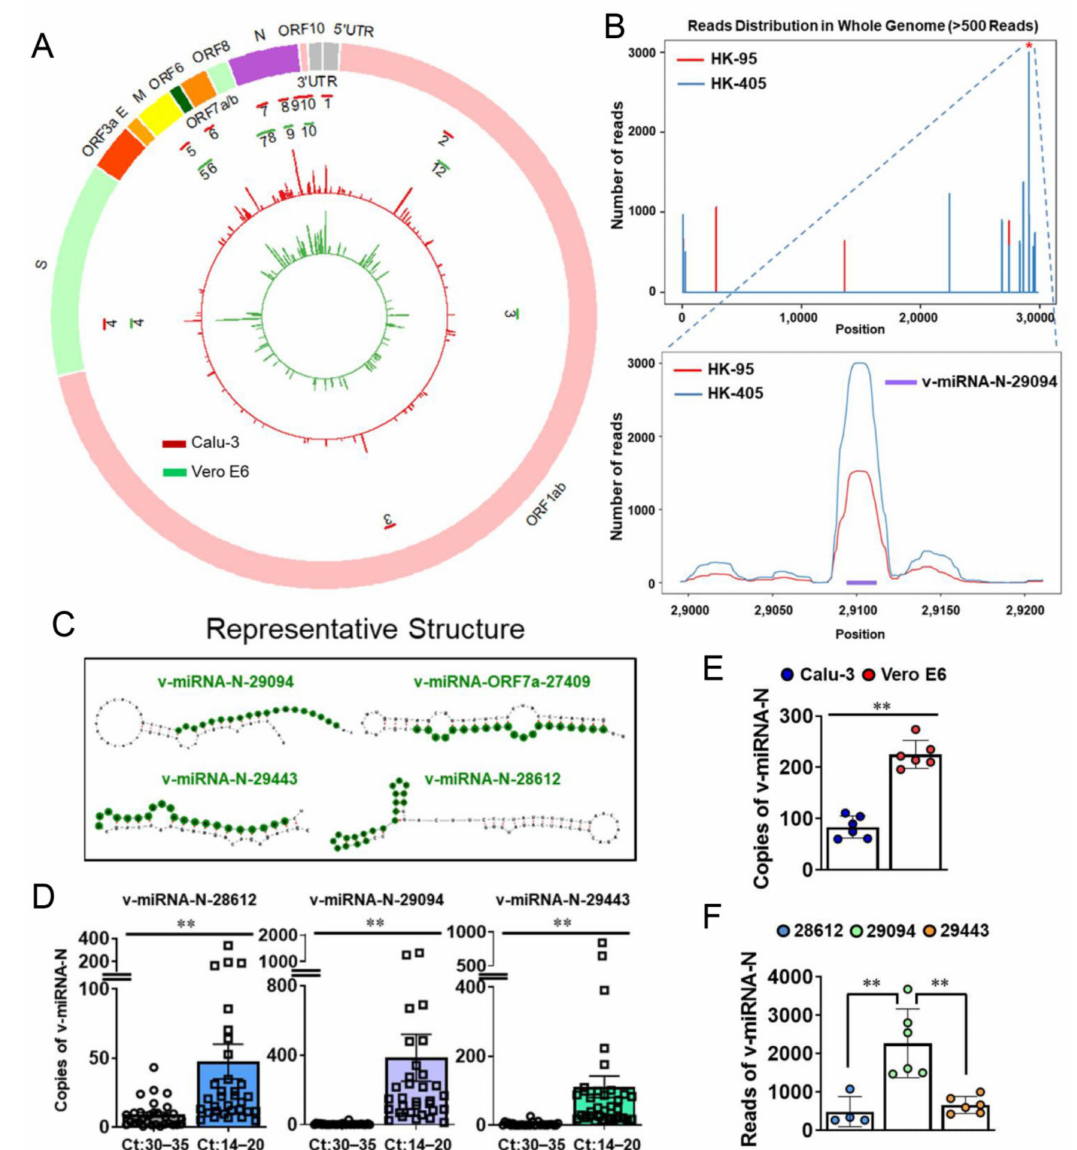
Figure 1. Detection of SARS-CoV-2-encoded v-miRNAs. ( A ) Genetic map and read distribution of SARS-CoV-2-encoded v-miRNAs in Calu-3 and Vero E6 cells. The inner green layer represents read distribution from Vero E6 cells and the middle red layer represents the read distribution of v-miRNAs from Calu-3 cells. The locations of the top ten v-miRNAs (in terms of read counts) are indicated as two circular layers of 10 short bars with the outer layer (red) for Calu-3 cells and inner layer (green) for Vero E6 cells. ( B ) Read distribution across the entire whole viral genome (>500 reads). The Y-axis shows the number of reads, and the X-axis shows the position of v-miRNAs. V-miRNA-N-29094 showed the highest peaks both in HK-95 and HK-405 samples isolated from Calu-3. ( C ) Representative predicted secondary structures of pre-miRNAs (gray). The encoded green color indicates the region for NGS-identified mature v-miRNAs. ( D ) Copy number of v-miRNA-N detected in COVID-19 patients. Significantly increased copy numbers of v-miRNA-28612, v-miRNA-229094, v-miRNA-29443 were detected in clinical samples from COVID-19 patients with high viral load (low Ct: 14–20) compared to those with low viral load (high Ct:30–35). The mean ± SD is shown for RT-ddPCR results. n = 30–33; ** p < 0.01. ( E ) Expression levels of v-miRNA-N-28612 are quantified by RT-ddPCR in Calu-3 and Vero E6 cells. The mean ± SD is shown for RT-ddPCR results. ** p < 0.01. ( F ) NGS reads of the identified three v-miRNA-N are determined in Calu-3 cells. The mean ± SD is shown for results obtained from small RNA-seq. ** p < 0.01. Ct, threshold cycle; E, envelope; HK, Hong Kong; M, membrane; N, nucleocapsid; ORF, open reading frame; S, spike; UTR, untranslated region; v-miRNA-N, viral microRNA